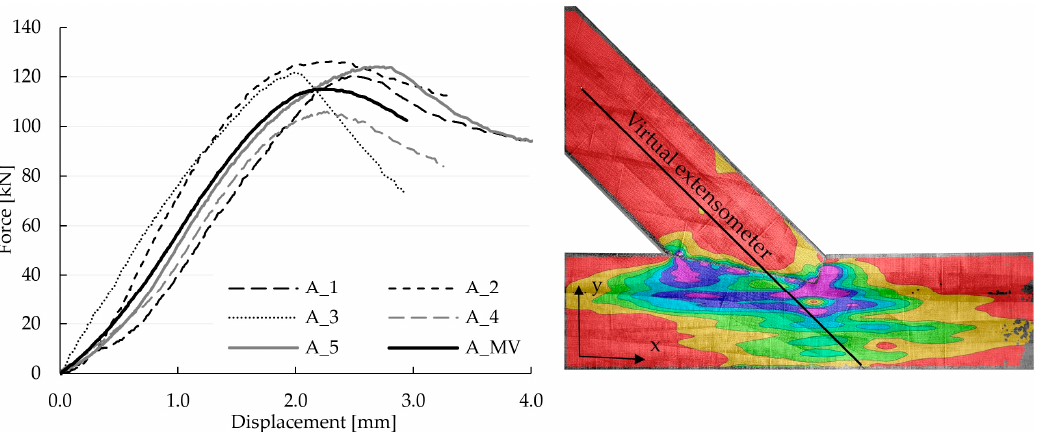
Figure 2. ( Left ): Force-displacement curves of all five test specimens of the single-step joints, as well as the mean value MV of the five specimens; ( Right ): Normal strains eyy at 90% of the ultimate load (124.08 kN) of specimen A_5 and visualisation of the virtual extensometer (based on the DIC measurement) used for the determination of the displacement, as well as the orientation of the coordinate system.